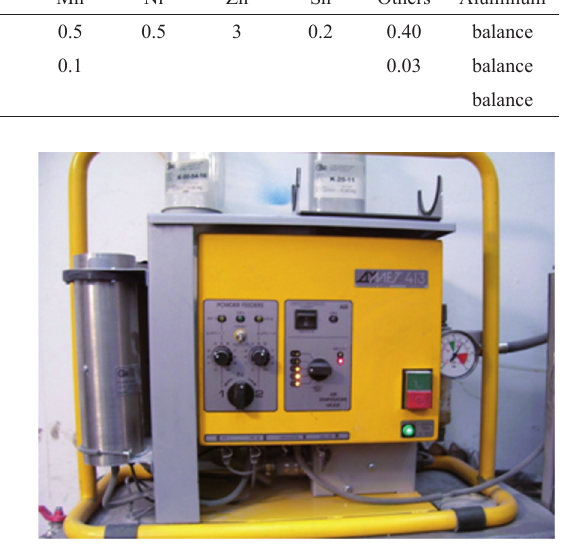
Figure 5: Low pressure Dymet equipment used for the spraying